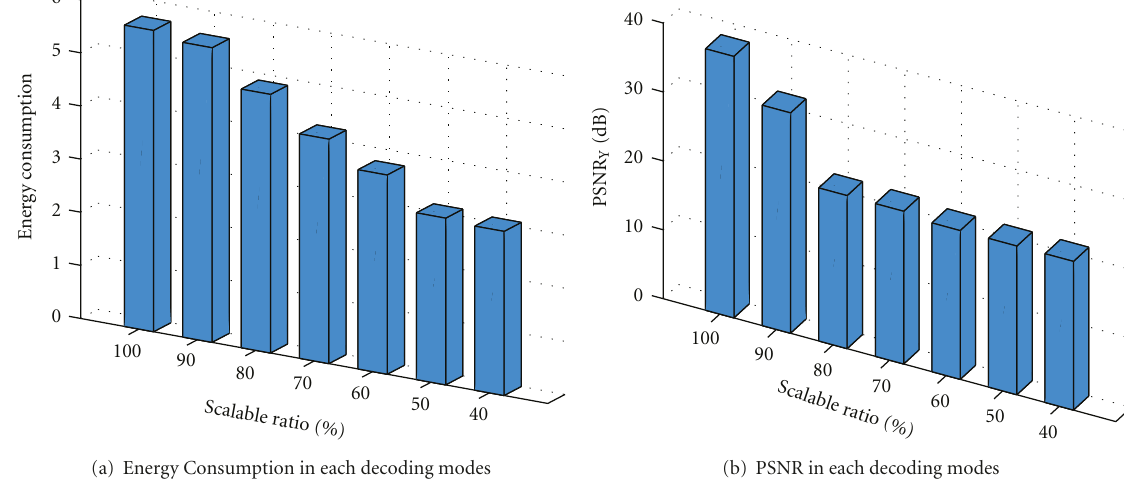
Figure 7: Influence on energy consumption and PSNR under di ff erent decoding